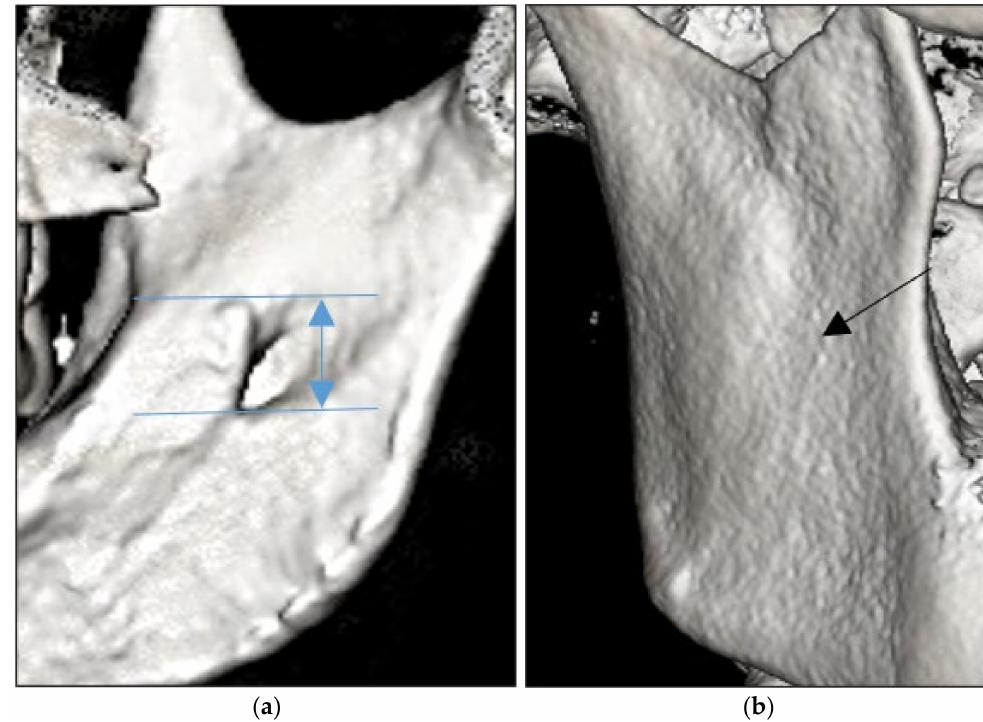
Figure 1. ( a ) Height of the lingula and ( b ) presence of the antilingula (arrow).